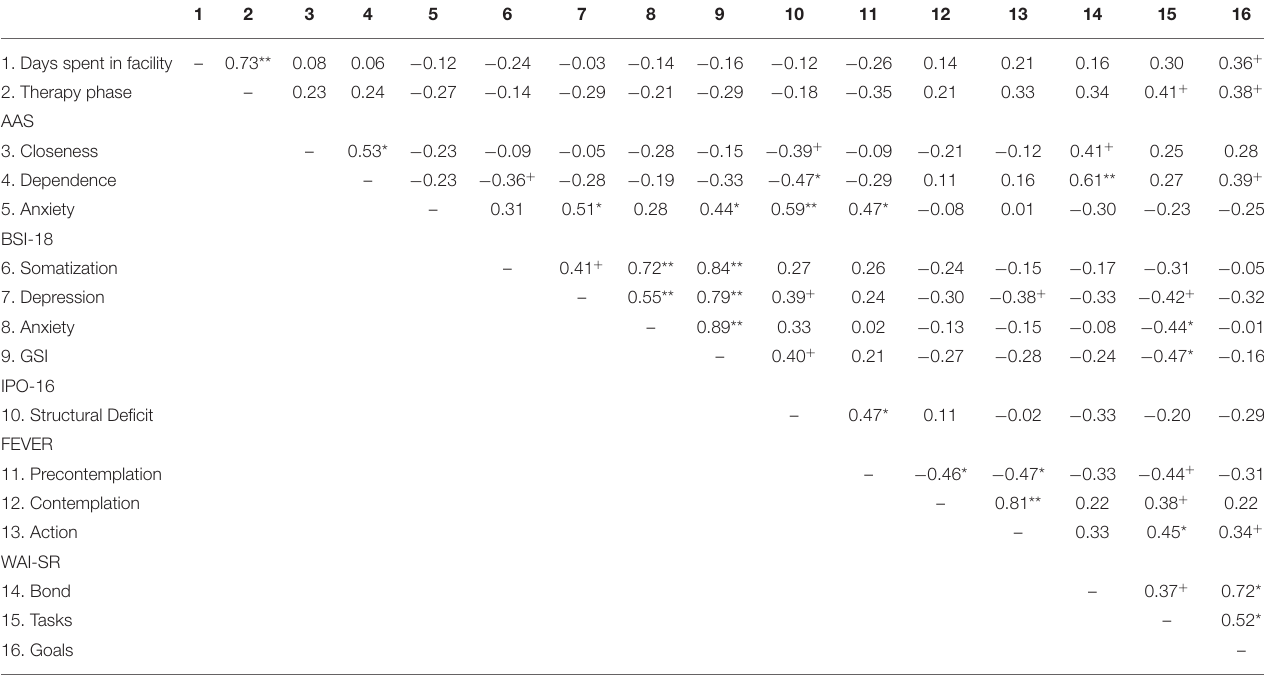
TABLE 3 | Intercorrelations for behavioral measures within the SUD sample ( n =